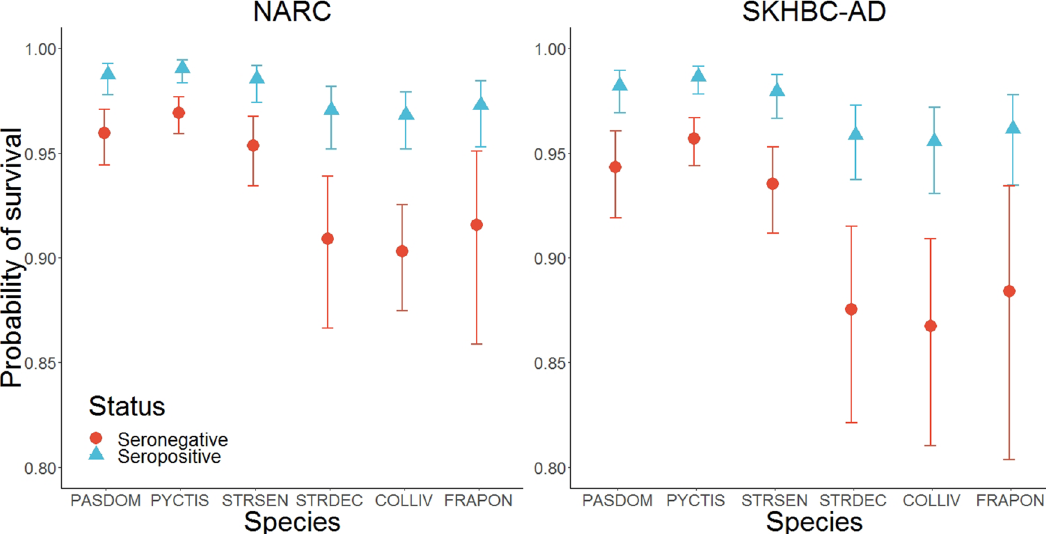
Figure 3. Probabilities of survival for each bird species according to the serological status of the individuals and the site of sampling. PASDOM stands for Passer domesticus , PYCTIS for Pycnonotus leucotis , STRSEN for Spilopelia senegalensis , STRDEC for Streptopelia decaocto , COLLIV for Columba livia and FRAPON for Francolinus pondicerianus. Error bars represent 95% confidence